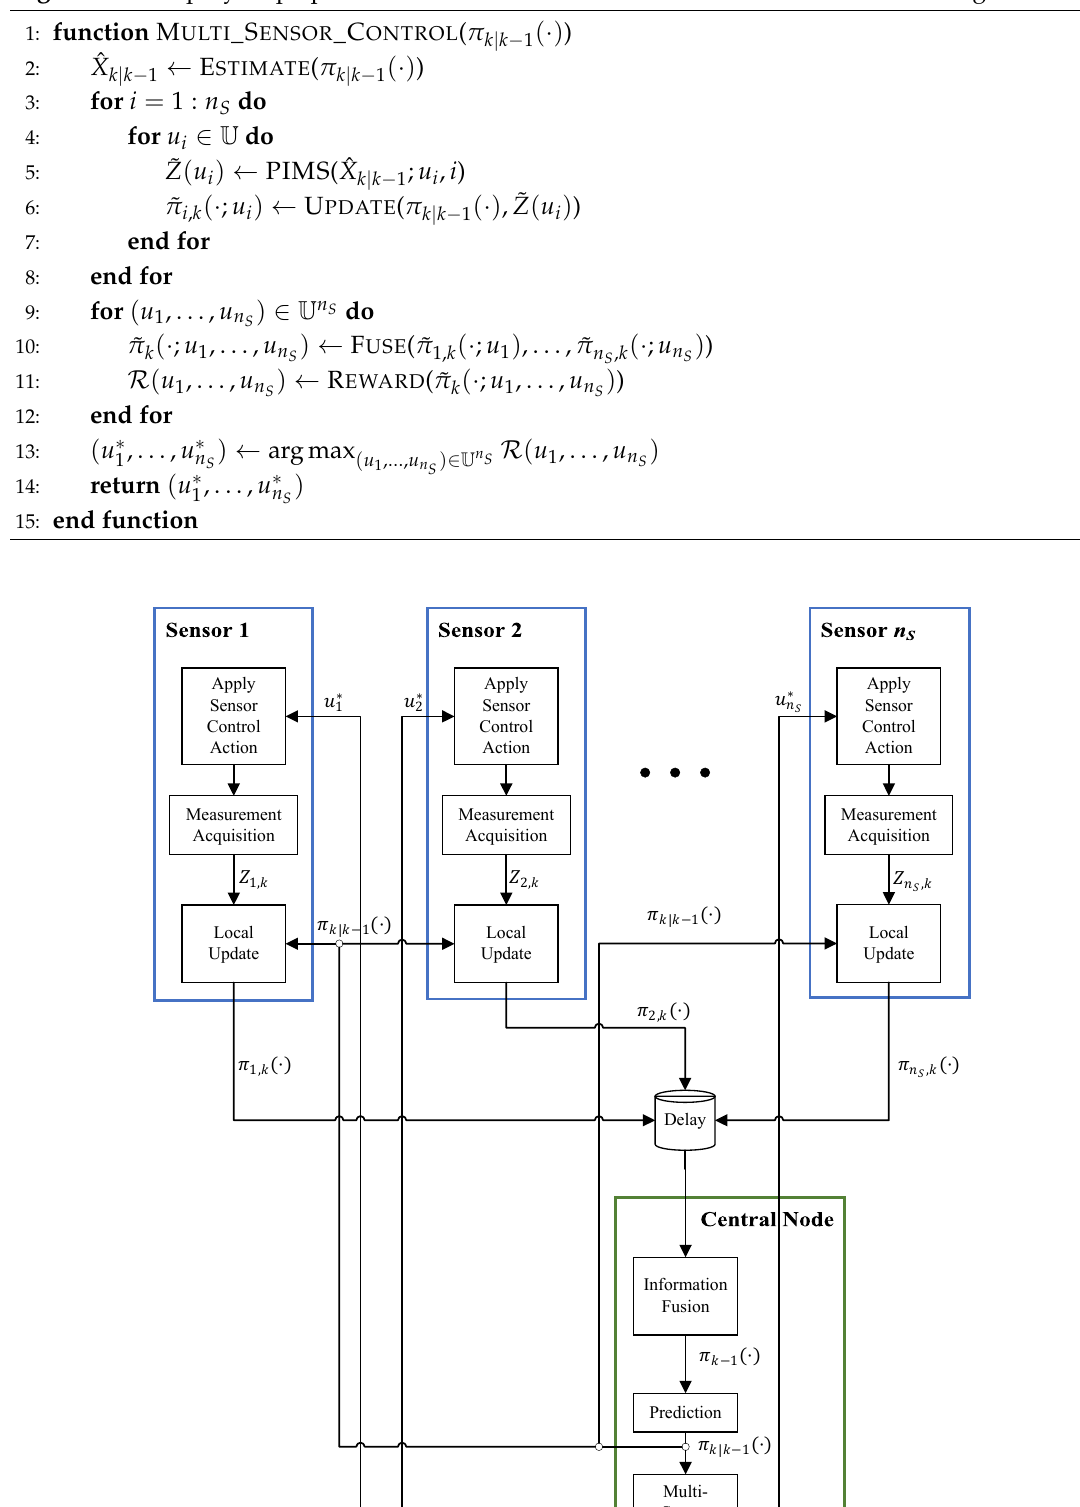
Algorithm 1 Step-by-step operations that run inside the multi-sensor control block in Figure 4.